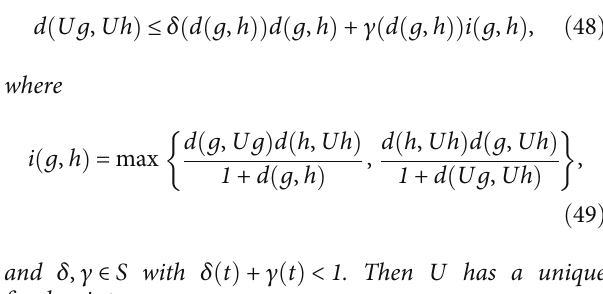
Figure 1: Graphical representation of inequality satisfying Example 2. Also showing the graph of curves y = point x = 1